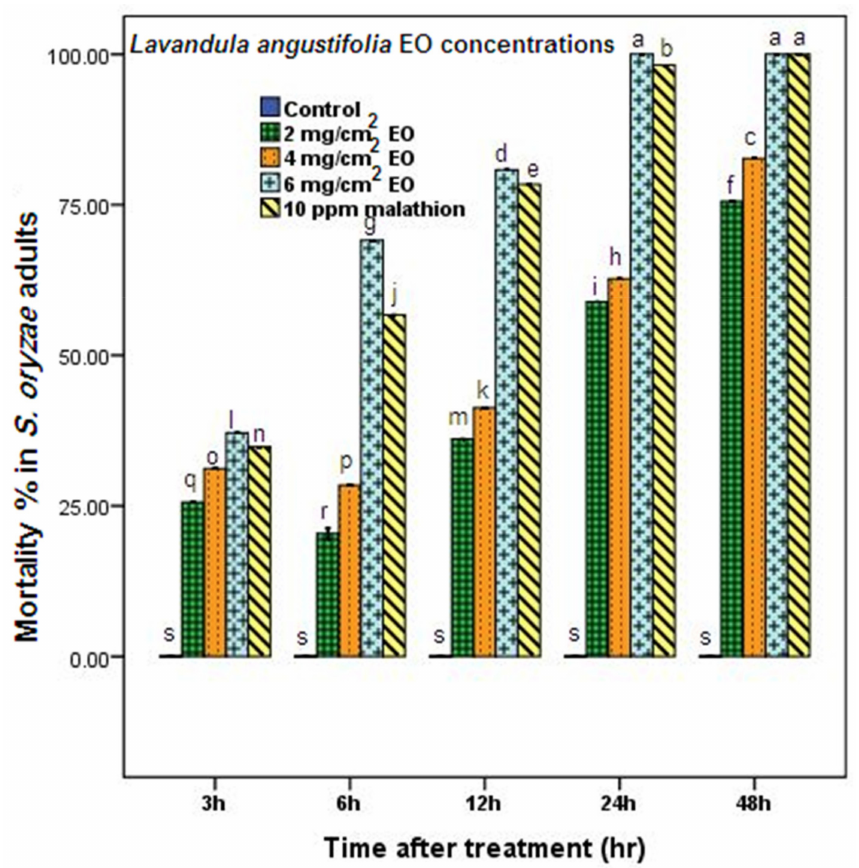
Figure 3. Impact of different concentrations (2, 4, and 6 mg/cm 2 ) from L. angustifolia EOs on mortality of S. oryzae adults at 3, 6, 12, 24, and 48 h exposure times (mean ± SD) compared with standard chemical pesticide (10 ppm malathion). Different letters indicate significant differences between different treatments at p < 0.05; LSD =